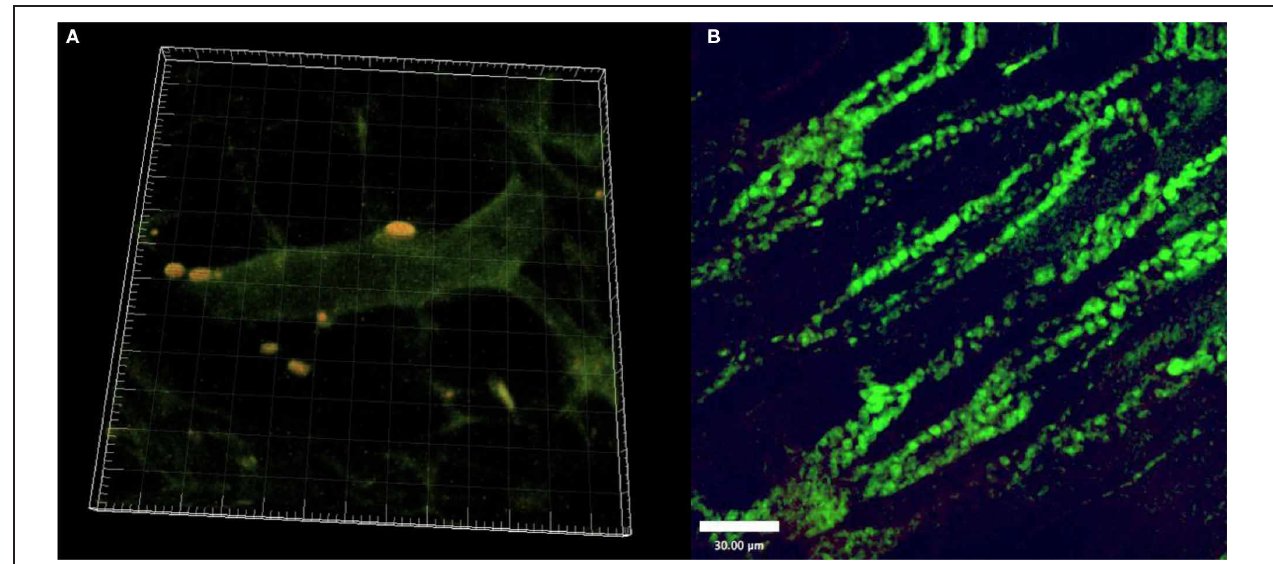
MSCs not only undergo phenotypic changes in culture and during passage (size, morphology, and cell surface marker expression) (Wagner et al., 2010; Hematti, 2012), but also lose capacity for func- tional proliferation and differentiation potential (Vacanti et al., 2005; Wagner et al., 2010). In addition, their ability for cytokine production is altered (Banfi et al., 2002; Vacanti et al.,